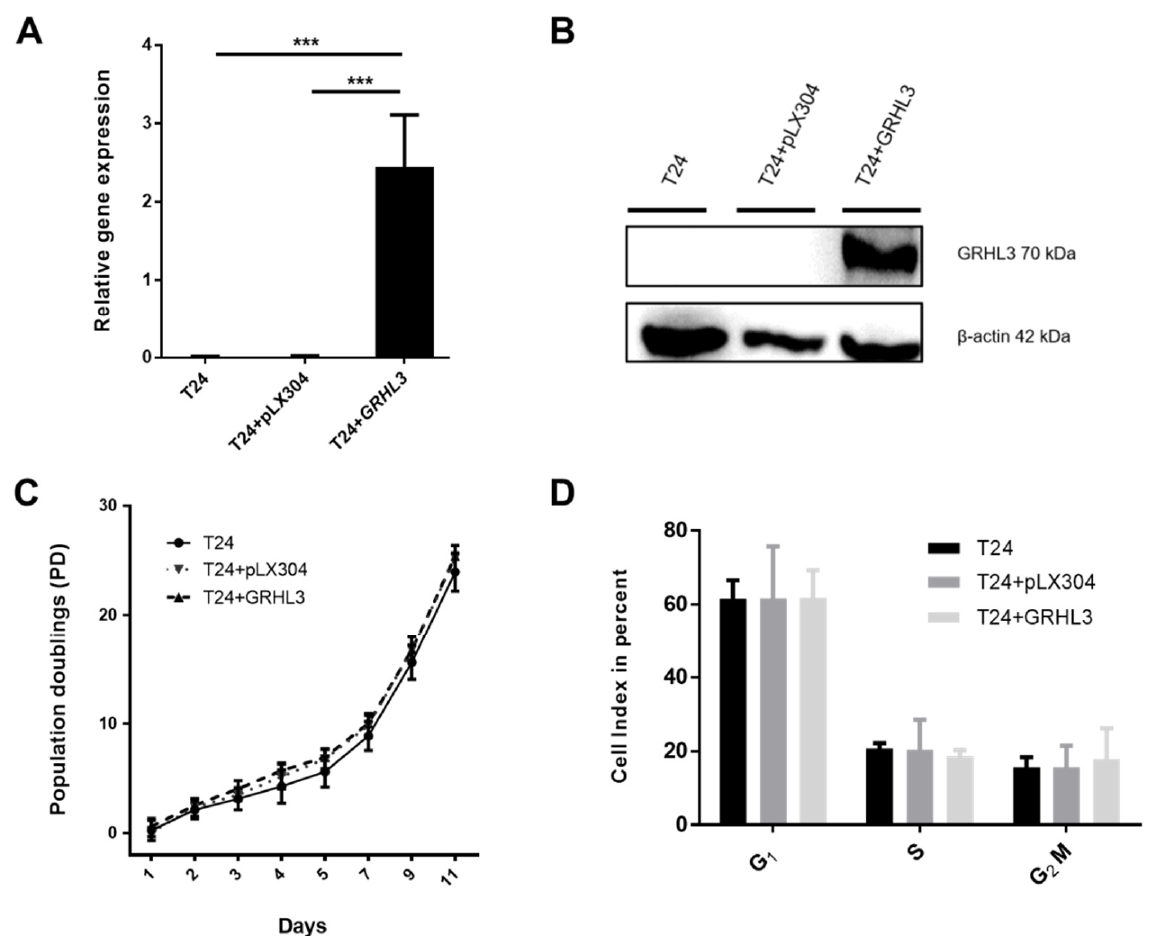
Figure 2. Ectopic expression of GRHL3 does not influence proliferation/survival rate and cell cycle profile of T24 cells ( A , B ) Forced stable expression of GRHL3 in T24 cells resulted in significantly higher transcript and protein expression levels compared to parental T24 cells and empty vector controls (pLX304). Three biological replicates were used for RT-qPCR experiments. *** indicates p -value < 0.001. ( C ) Calculated population doublings using Thiazolyl blue tetrazolium bromide (MTT) assays were comparable between GRHL3-overexpressing T24 cells, parental T24 cells and empty vector controls after 11 days in culture (T24 vs. T24 + pLX304 vs. T24+GRHL3: 23.92 vs. 25.19 vs. 25.40 population doublings (PD) at day 11; n.s). ( D ) Cell cycle analysis was performed by Propidium iodide (PI) staining and relative amounts of cells in the respective cell cycle phases are indicated. No difference could be observed in G1, S or G2/M phases between parental cells, empty vector controls and ectopic GRHL3-expressing cells (statistically n.s.).